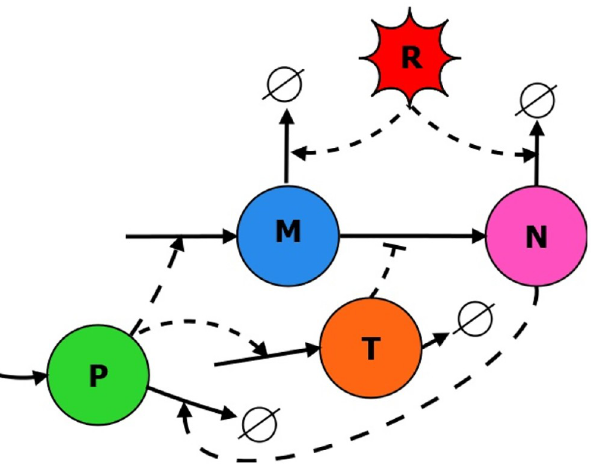
Fig 1. The scheme of the P53 regulatory module model. P stands for nuclear p53, M for cytoplasmic Mdm2, N for nuclear Mdm2 and T for cytoplasmic